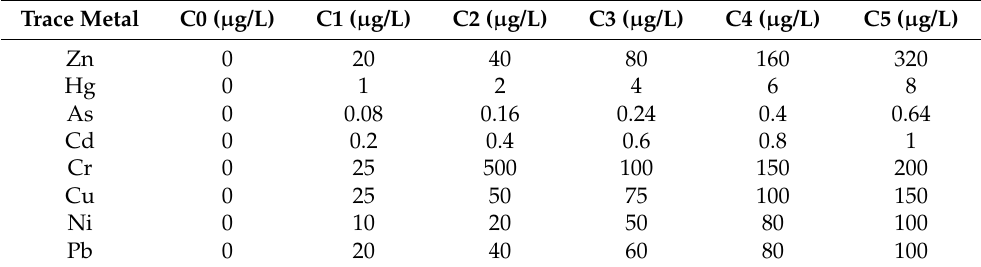
Table A1. Standard series of solutions concentration (fish and sediment).